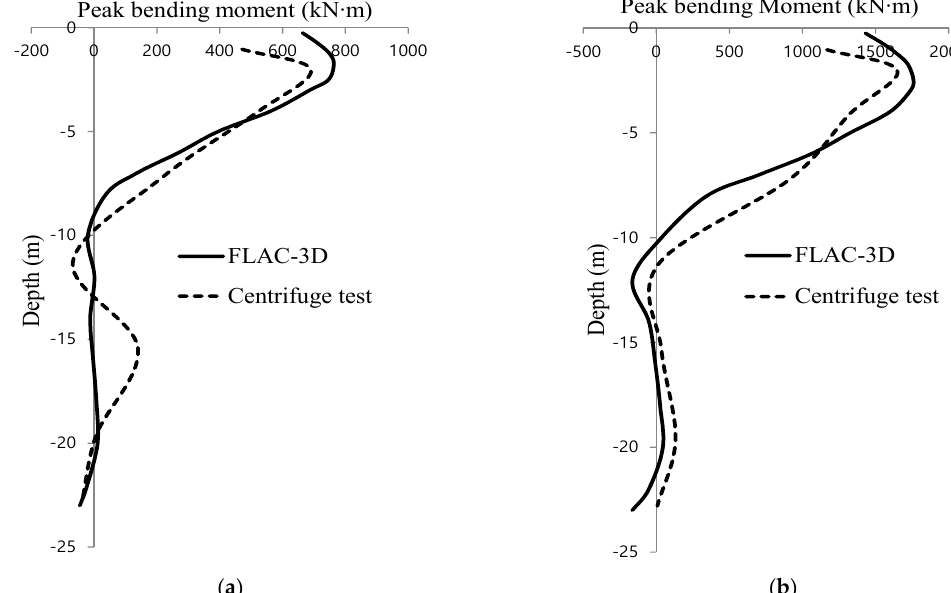
Figure 10. Measured and calculated peak bending moment profiles (Model 1, Ofunato earthquake): ( a ) Ofunato, 0.13 g; ( b ) Ofunato, 0.51 g.